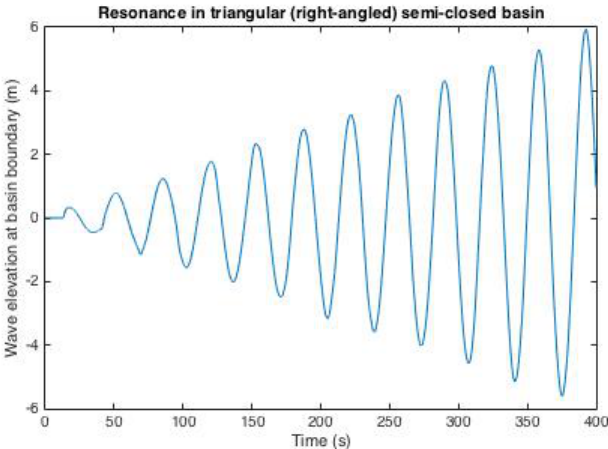
Figure 8. Simulation result for triangular (right-angled) semi-closed